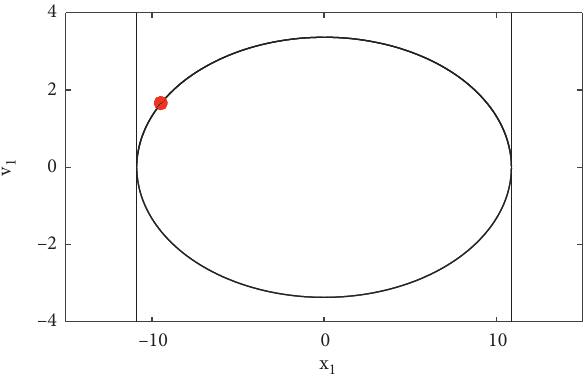
Figure 7: A grazing periodic trajectory of oscillator M